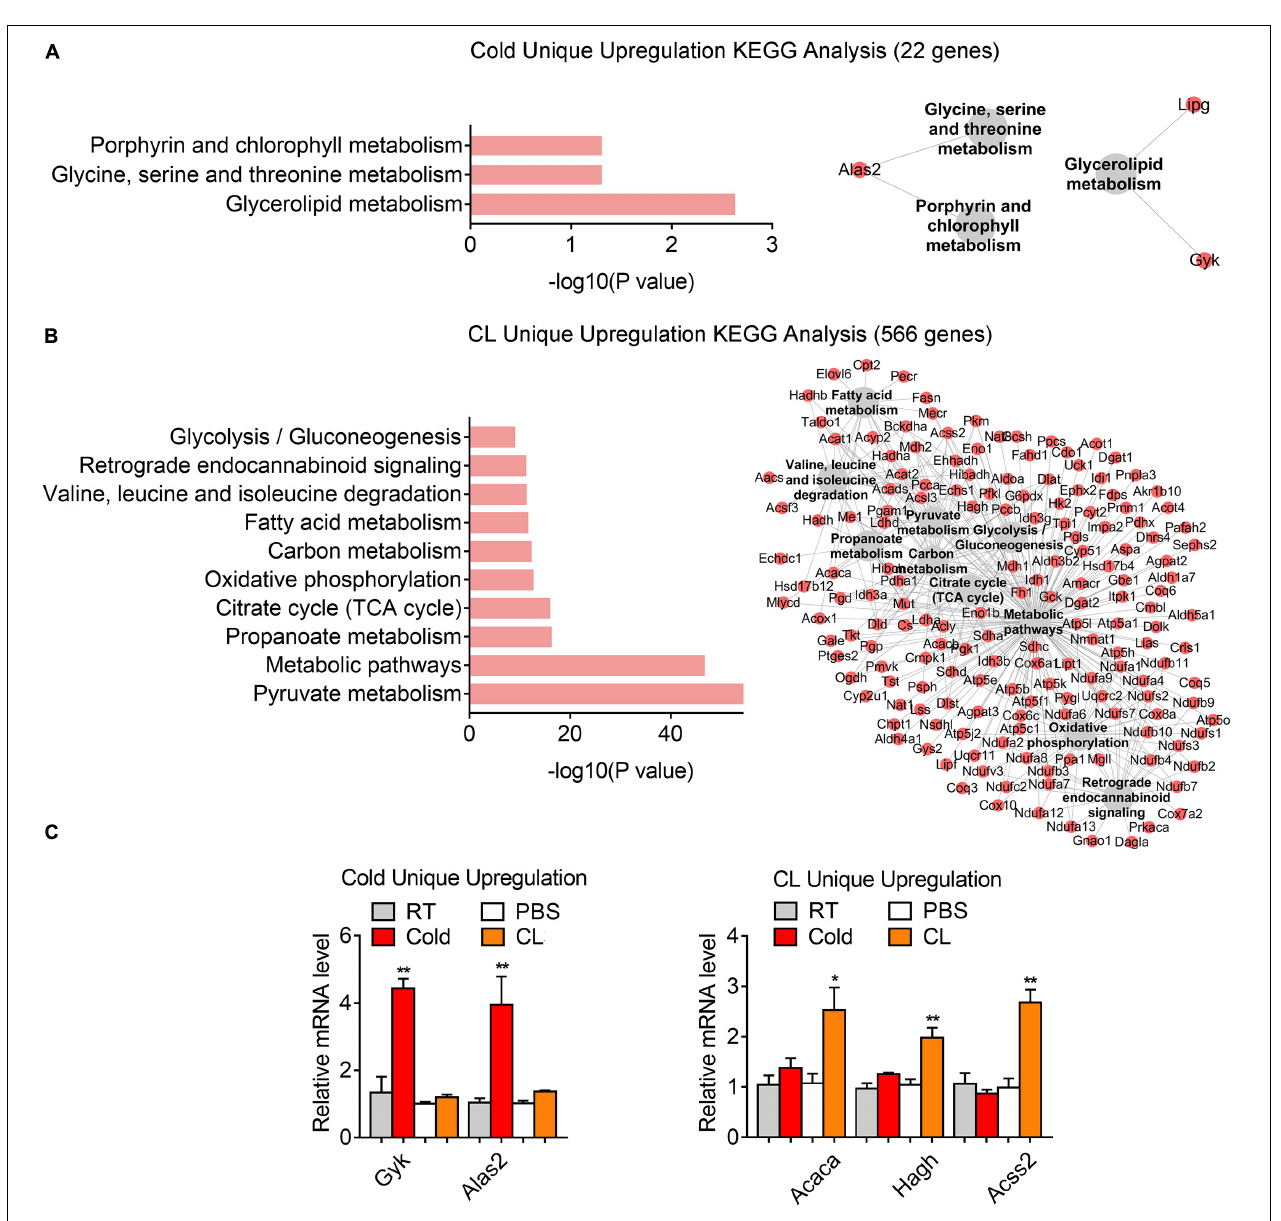
FIGURE 7 | Analysis of uniquely upregulated gene programs of cold exposure and CL administration. (A,B) KEGG analysis and pathway-gene network for uniquely upregulated DEGs [ (A) 22 genes in cold datasets, (B) 566 genes in CL datasets]. (C) mRNA levels of top ranked genes exclusively upregulated in iWAT of mice under cold exposure or CL administration. N = 6 per group. Data are presented as mean ± SEM and * P < 0.05, ** P < 0.01 compared to control